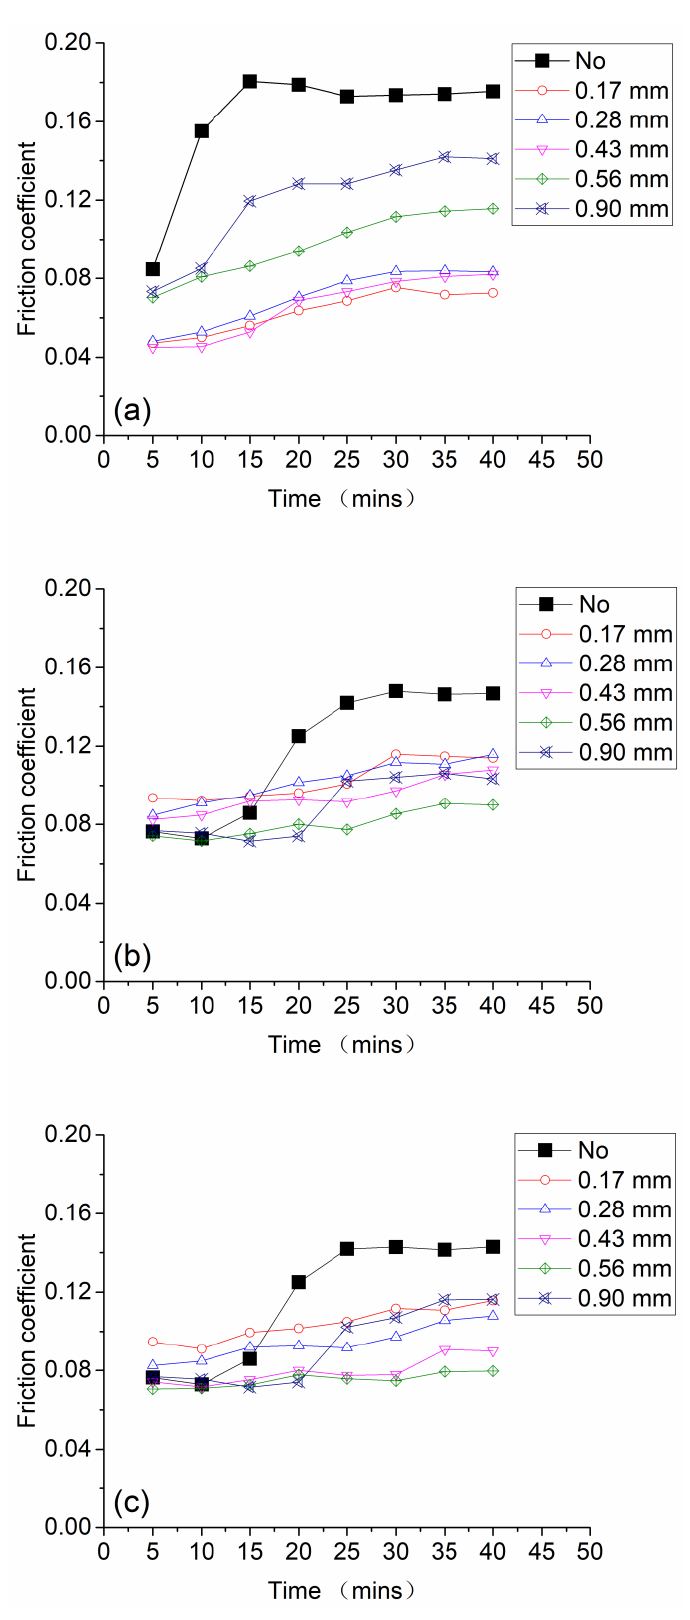
Figure 3. Variation curves of friction coefficient between steel–straw powder–steel with different particle sizes: ( a ) no lubricant; ( b ) lubricating oil; ( c ) lubricating grease